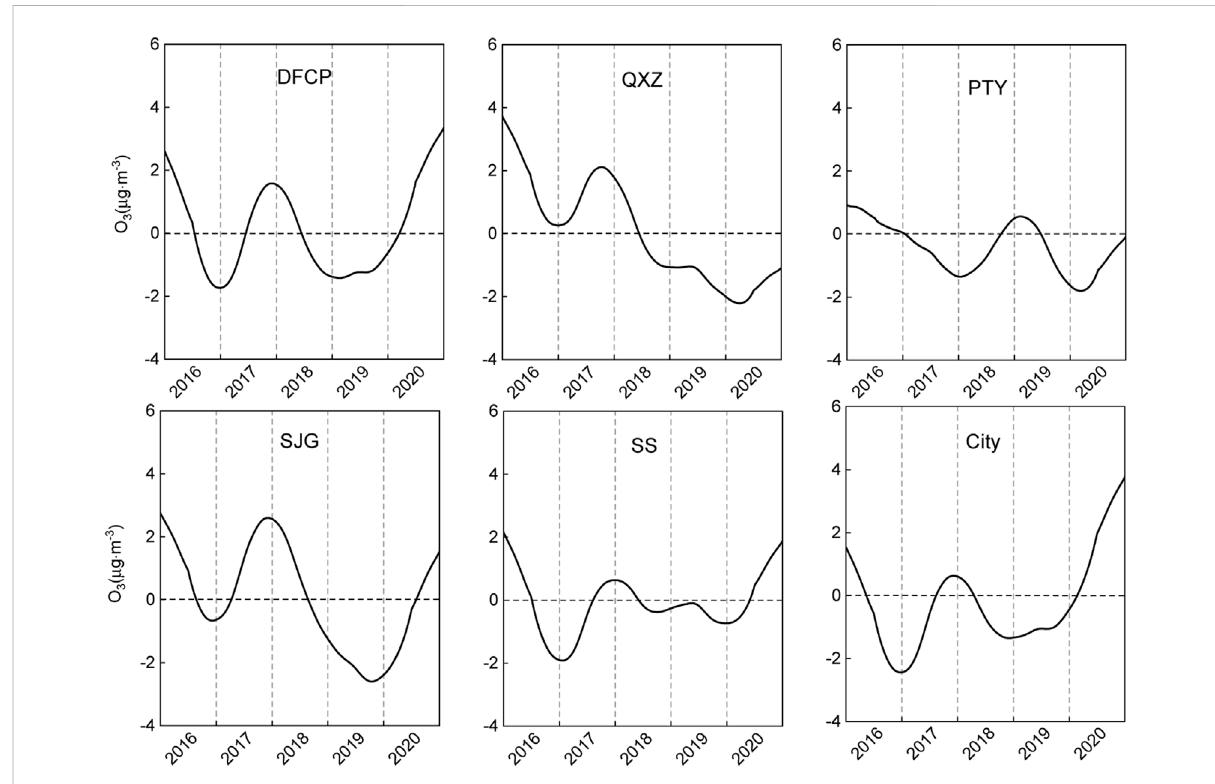
FIGURE 7 Assessment of the in fl uence of weather conditions on the long-term variation of ozone in the city and fi ve districts within the city. DFCP, Dongfeng Chemical Plant site, QXZ, Qixiangzhan, PTY, Putianyuan site, SJG, Sanjin Group site, SS, Shuangshan site and City: Zibo